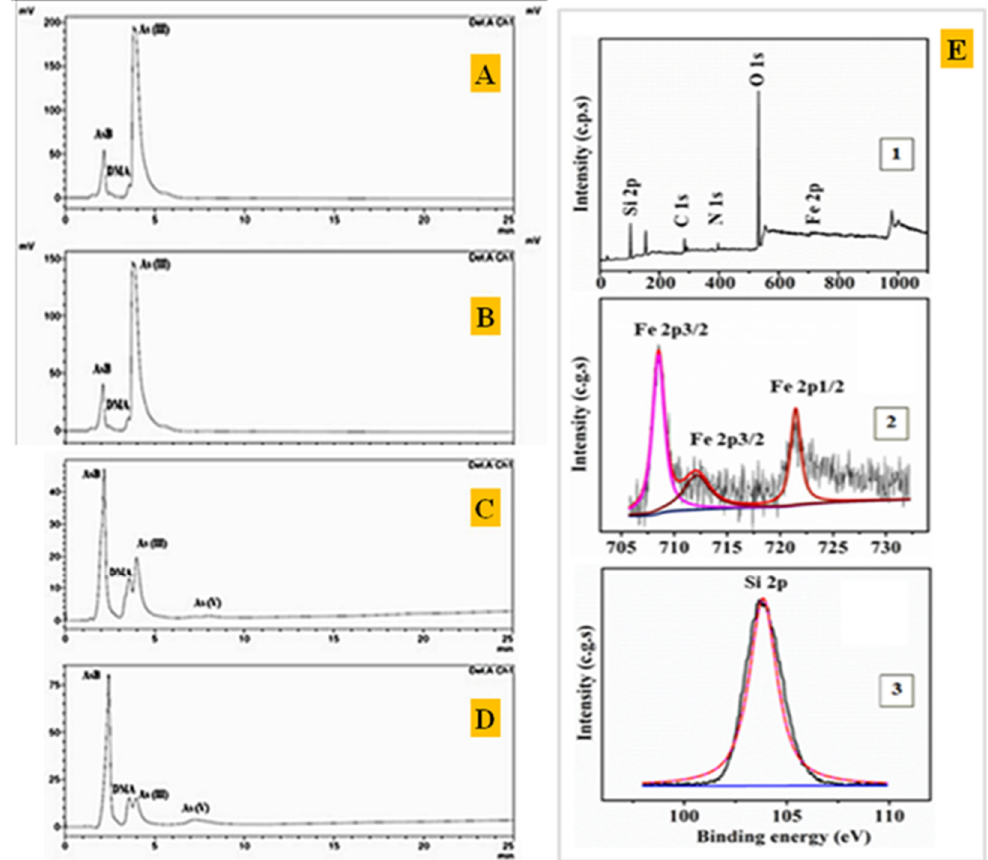
Figure 10. Ion chromatogram obtained during HPLC speciation of species present in the sample . ( A ) Standard As(III) (5 ppm) solution at pH=6.5). ( B ) Standard As(III) sample (5 ppm) after PBN@SiO 2 treatment in acidic medium (pH=2). ( C ) As(III) standard solution (5 ppm) after PBN@SiO 2 treatment in neutral medium (pH = 6.5). ( D ) As(III) standard sample (5 ppm) after PBN@SiO 2 treatment in alkaline medium (pH=8.5). ( E ) XPS analysis of PBN@SiO 2 . ( 1 ) A complete survey scan with all recognized species. ( 2 ) Fe+2 and Fe+3 species XPS peak in PBN@SiO 2 . ( 3 ) Iden- tified Si (IV) chemical states in SiO 2 . Table 2. All arsenic species (As(III), DMA, AsB) identified at different retention times along with their relative concentration during HPLC. Species As III As III Sodium arsenite